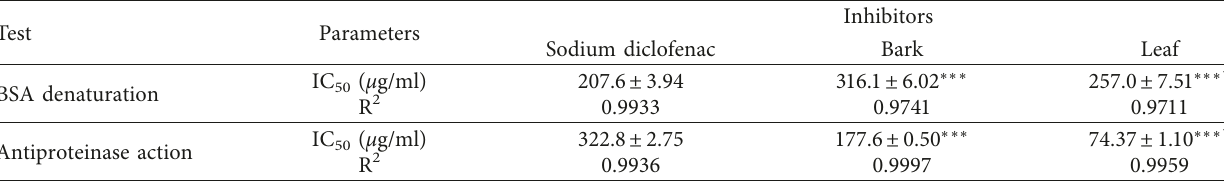
Table 4: IC 50 and correlation coefficient ( r ) of hydro-ethanolic leaf and bark extracts in BSA denaturation and antiproteinase assay compared to sodium diclofenac.